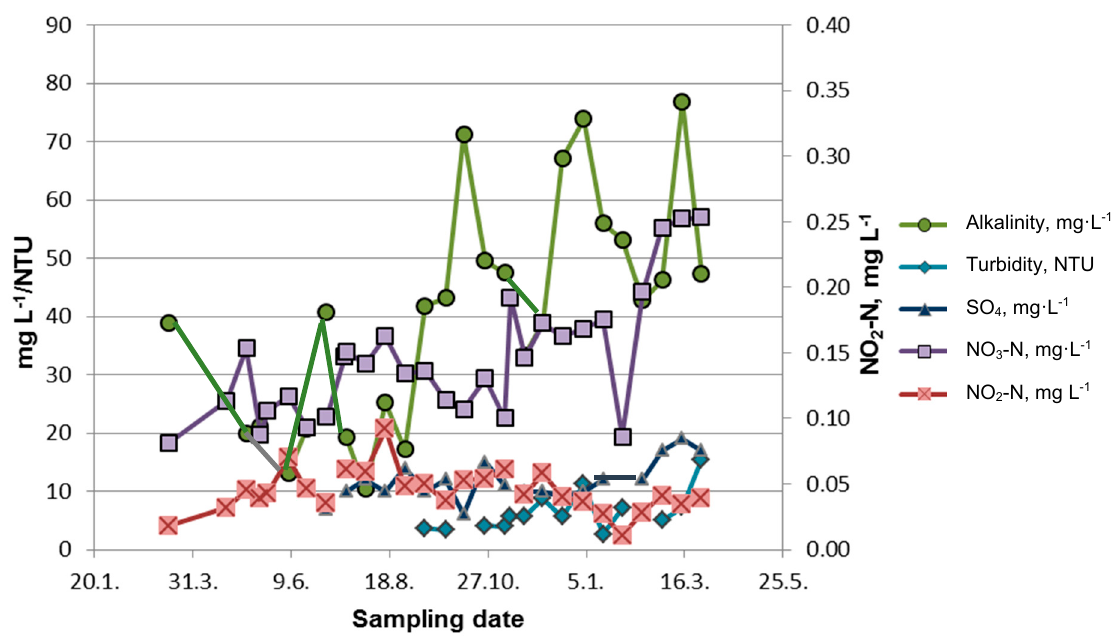
Figure 6. Measured parameters of water quality: alkalinity, NO 2 -N, NO 3 -N, SO 4 2 − (mg · L − 1 ), and turbidity (NTU) in RAS rearing rainbow trout (Oncorhynchus mykiss), and European whitefish (Coregonus lavaretus) over the course of the